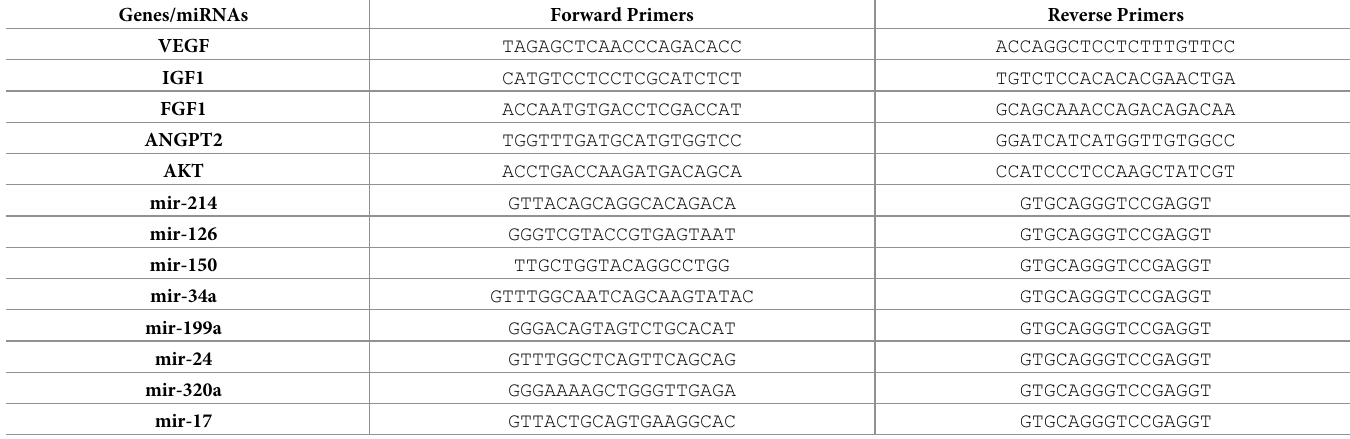
Table 2. Target genes and miRNA